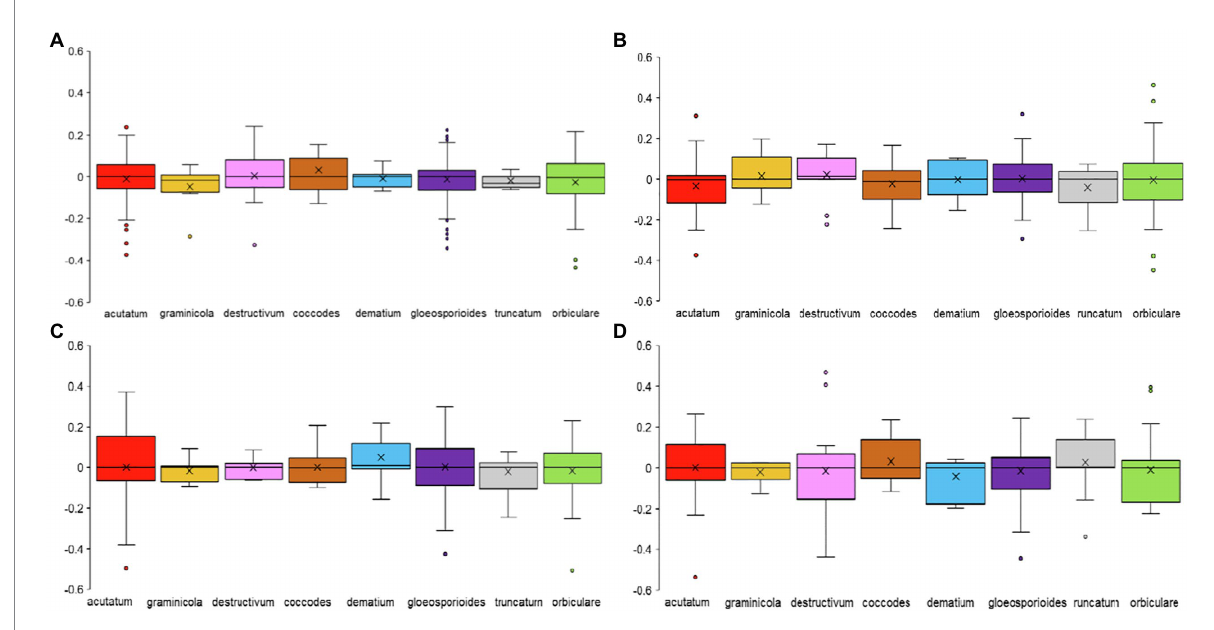
FIGURE 4 Box-plot of the residuals of observed data for (A) mycelial growth, (B) conidial germination, (C) infection, and (D) sporulation of Colletotrichum spp. versus the data estimated by Equation (1) for the clades to which species belong. Clades are indicated by different colors: red is acutatum, orange is graminicola, pink is destructivum, brown is coccodes, blue is dematium, purple is gloeosporioides, gray is truncatum, and green is orbiculare.